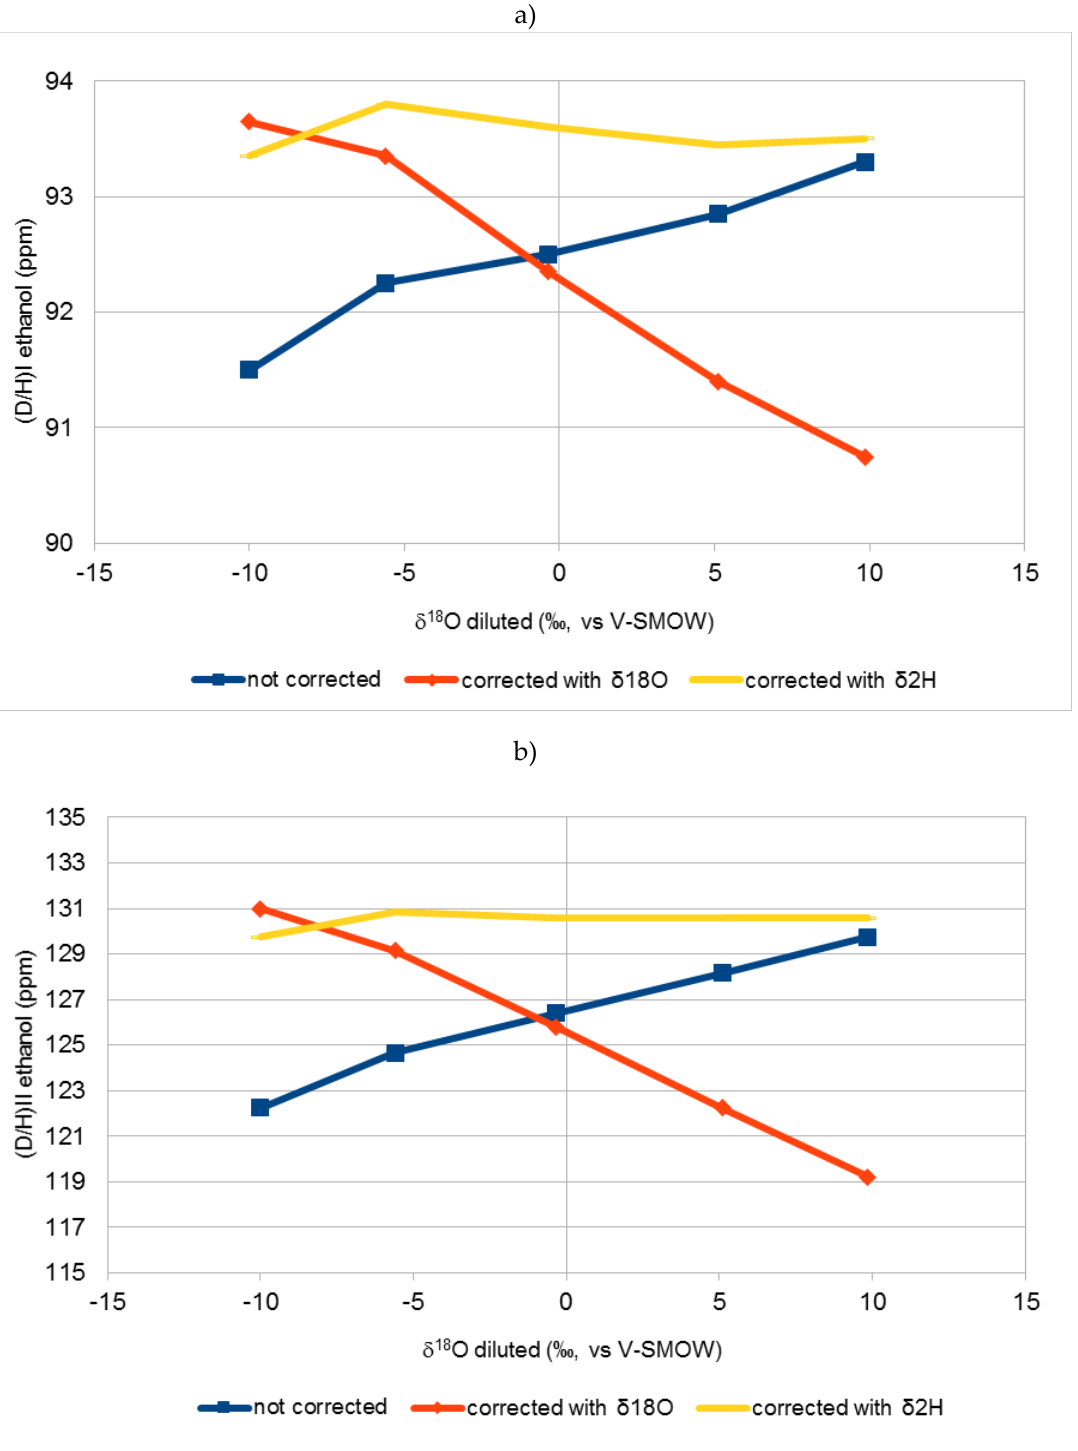
Figure 2 . Variation of uncorrected (D/H) I ( a ) and (D/H) II ( b ) values of ethanol vs. δ 18 O of water of diluted beet sugar samples (red line) and effect of the correction on the (D/H) I ( a ) and (D/H) II ( b ) of ethanol (Equations (1) and (2)) using δ 18 O (Equation (5)) (blue line) and δ 2 H (Equation (6)) (yellow line), values reported in Table 1 of the diluted sugar samples. Each point is the mean of two samples.